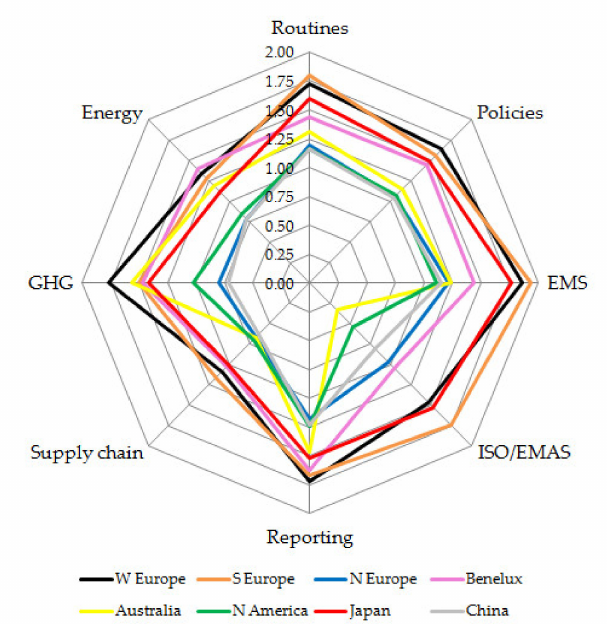
Figure 2. Mean values of grades obtained by regions in assessed indicators. The most homogeneous group in terms of obtained overall ratings was Western Europe, whose coefficient of variation was 35.56%. The highest diversity was observed in Northern Europe with v = 74.61%.